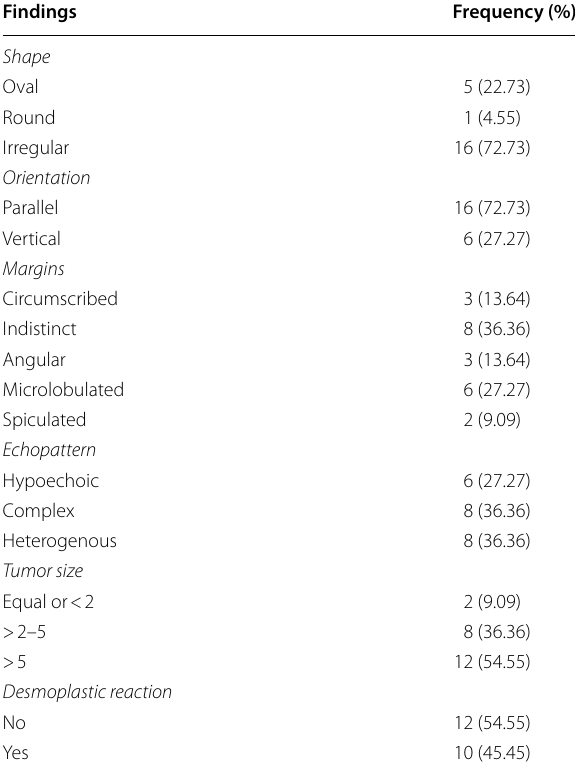
22) Table 4 Pathological and surgical characteristics ( n =